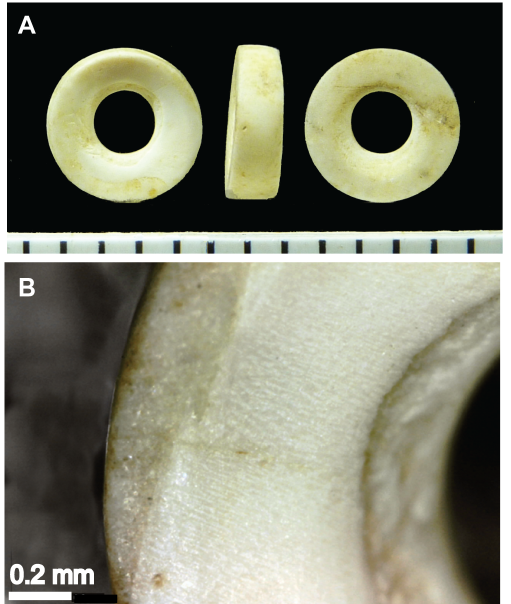
Figure 5. Great Cornard bead 3682. (a) Photograph and (b) photomicrograph of the surface. The bulk of the bead is granular but this surface has the remnants of a thin layer of a whiter, more opaque material with a finely striated appearance.